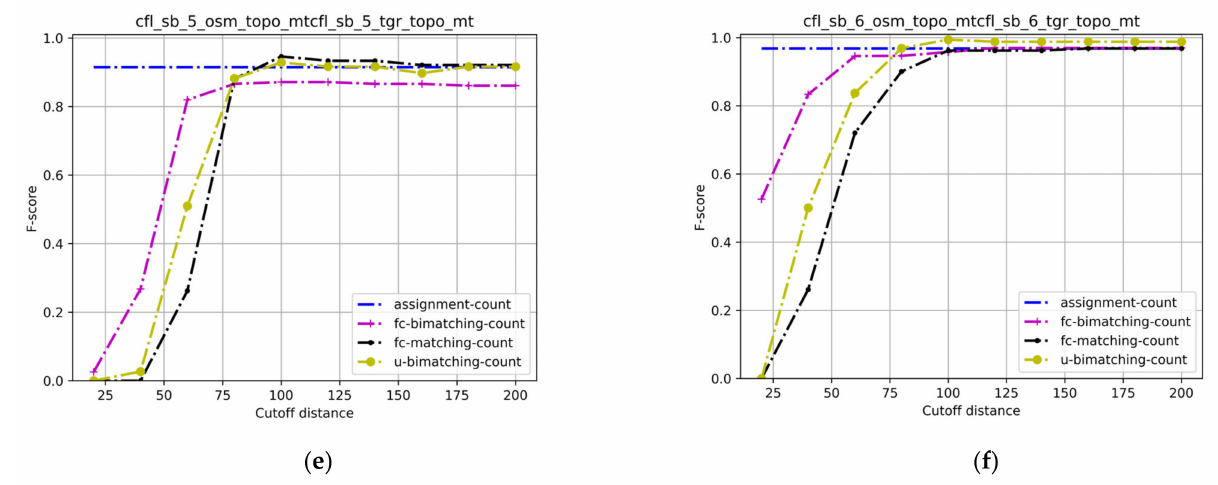
Figure 6. F-score of optimized conflation models for the Santa Barbara dataset (OSM vs. TIGER). ( a – f ) Results for sites #1 through #6.